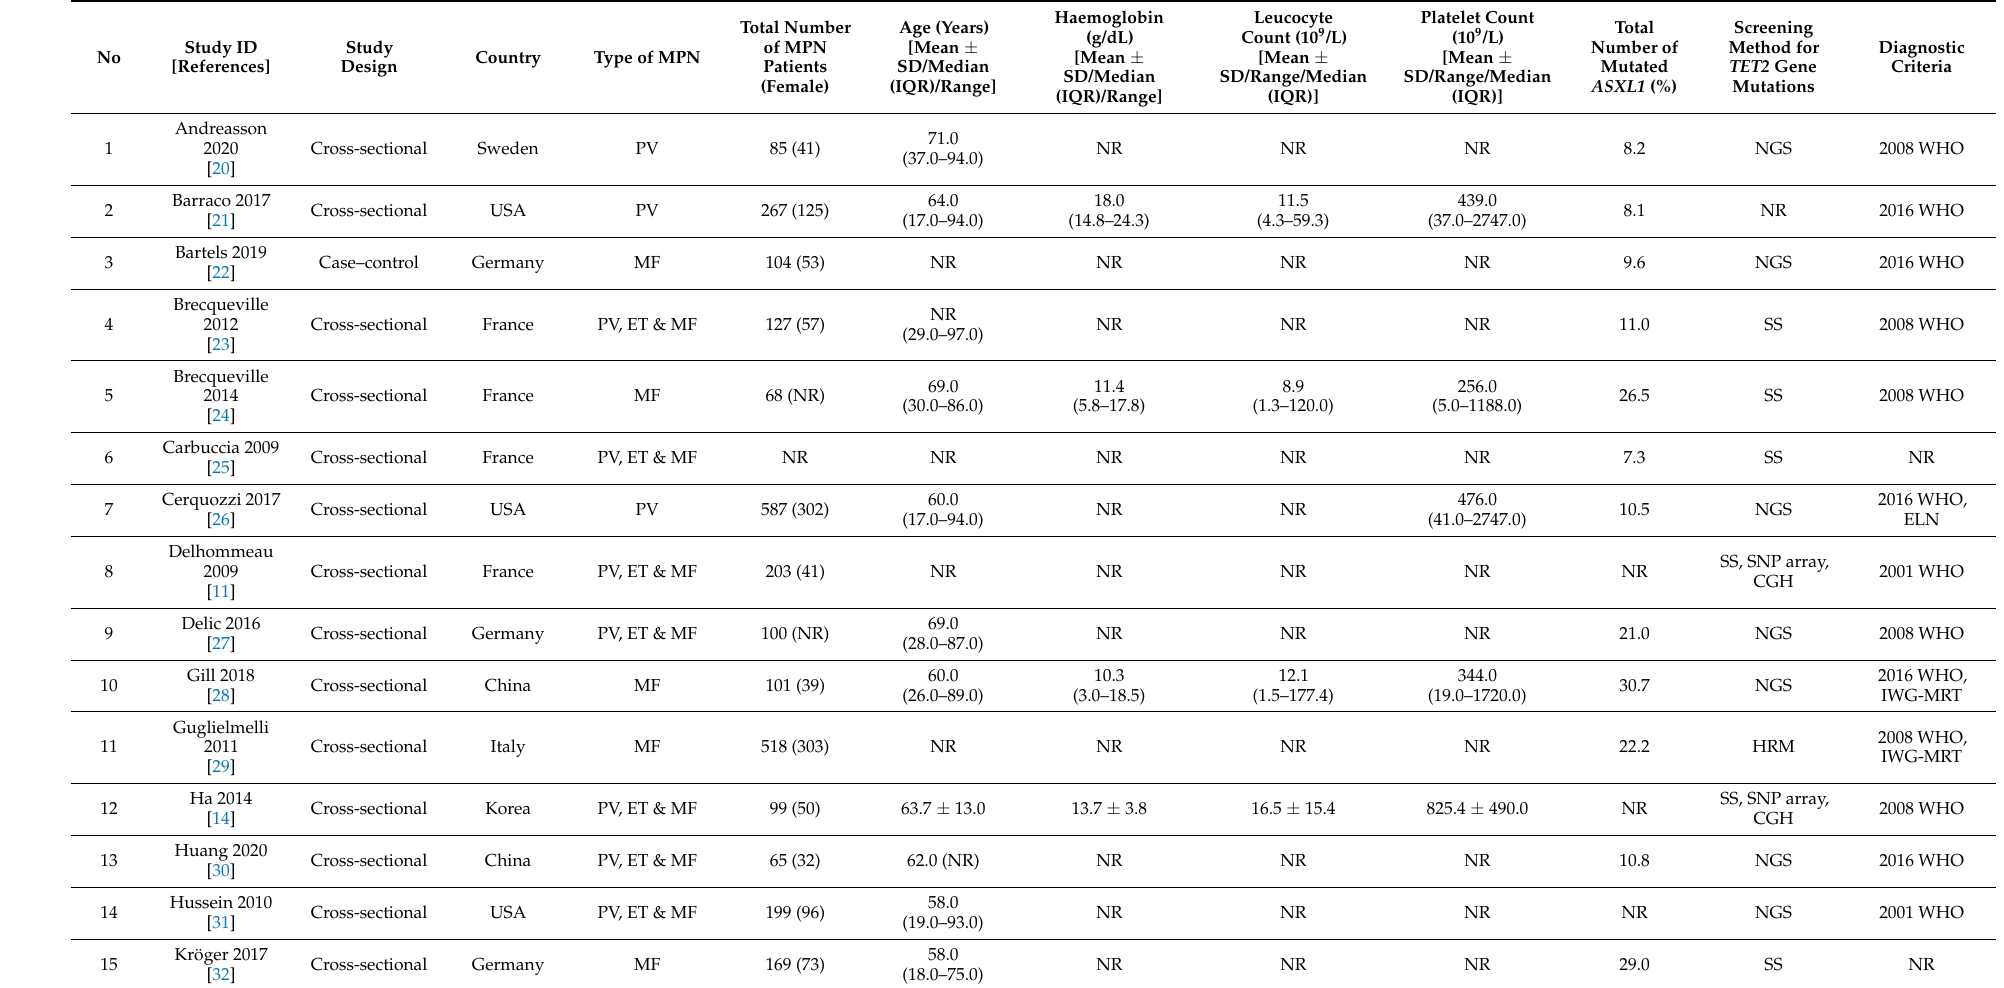
Table 1. Major characteristics of the included